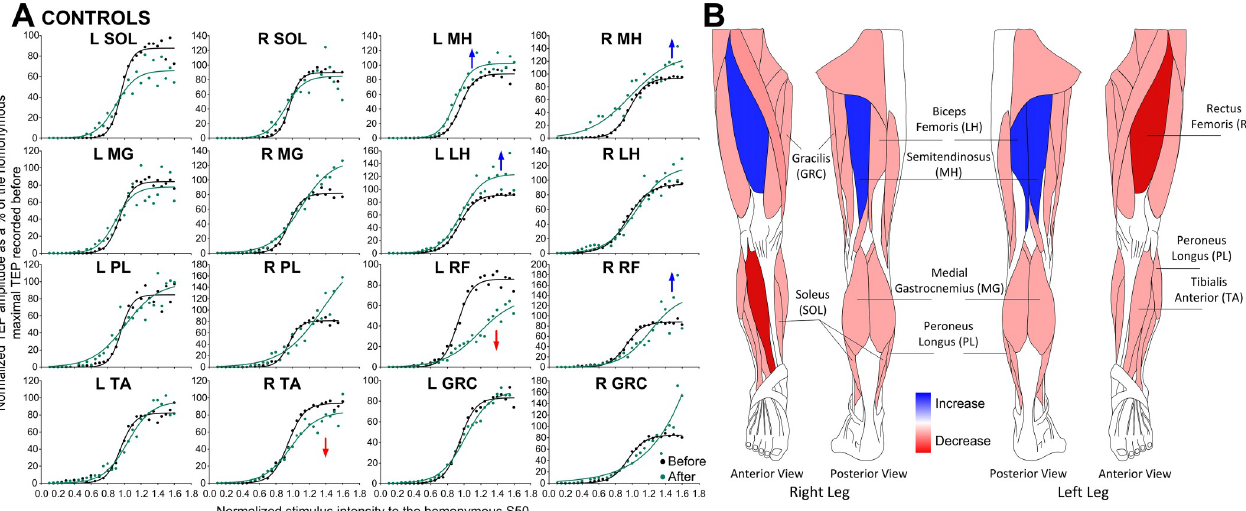
Fig 4. Transspinal evoked potential (TEP) recruitment curves before and after transspinal stimulation in healthy control subjects. (A) TEPs normalized to the homonymous maximal TEP and plotted against normalized stimulation intensities to the S50-TEPmax obtained before transspinal stimulation training along with the sigmoid function fitted to the data. (B) Schematic representation of changes observed in the TEP recruitment input-output curves where red represents an increase and blue represents a decrease in the corresponding muscle from which the TEP was recorded. SOL: soleus; MG: medial gastrocnemius; TA: tibialis anterior; PL: peroneus longus; MH: medial hamstring; LH: lateral hamstring; RF: rectus femoris; GRC: gracilis. An asterisk indicates a significant difference before and after transspinal stimulation.